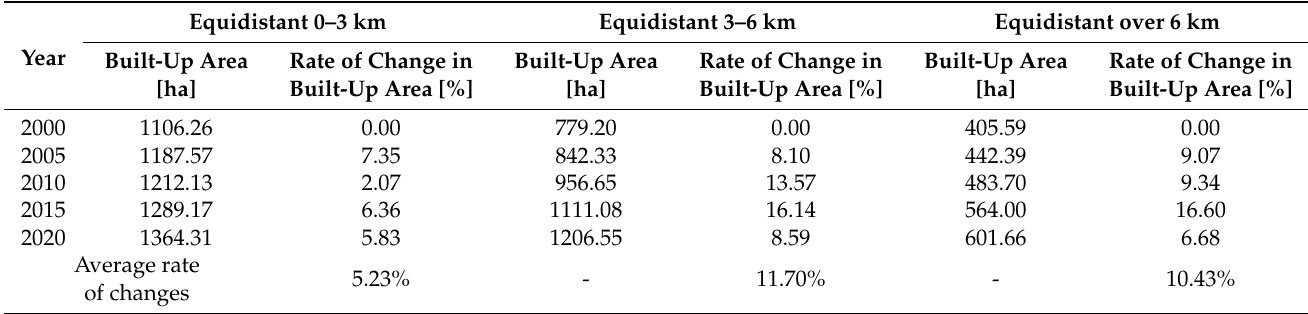
Table 6. Rate of change in built-up areas in particular buffer zones from the centre of Opole obtained from processing of Landsat satellite images (2000, 2005, 2010, 2015, and